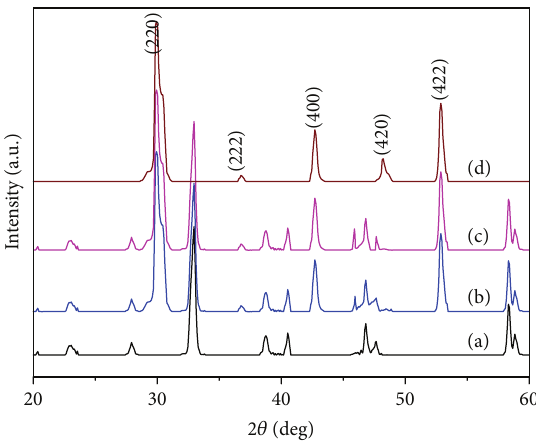
Figure 2: XRD patterns of (a) pure 100% YBCO, (b) 50% YBCO + 50% SBNO, (c) 70% YBCO + 30% SBNO, and (d) 100% SBNO.